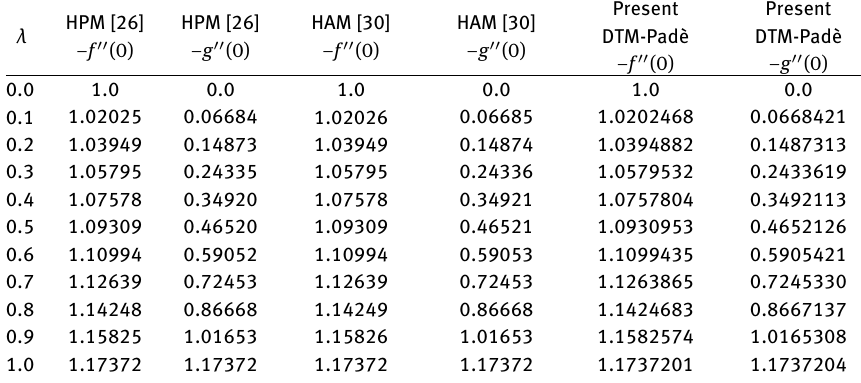
Table 3: A comparative study for the velocity gradients for various values of λ when β 1 = 0, β 2 = 0 with 20 th order DTM-Padè solution